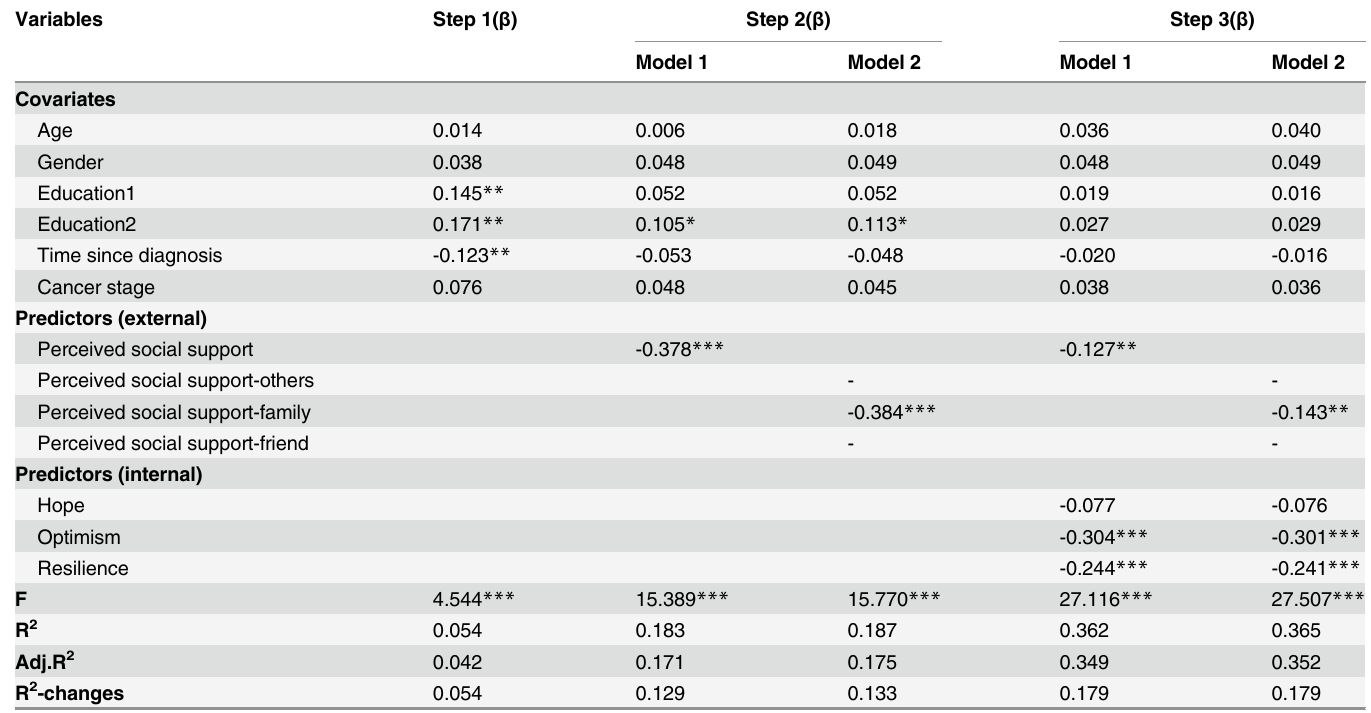
Table 4. Hierarchical regression analyses for psychosocial resources predicting